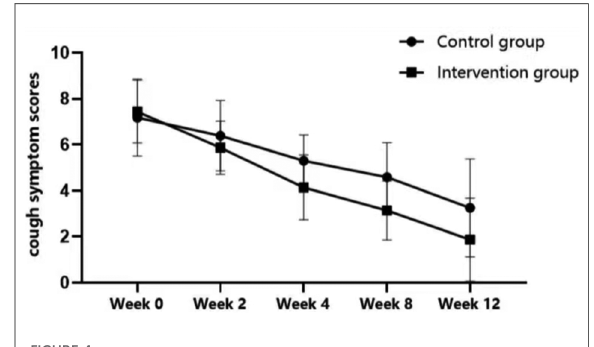
FIGURE 4 Comparison of cough symptom scores between control and intervention groups.